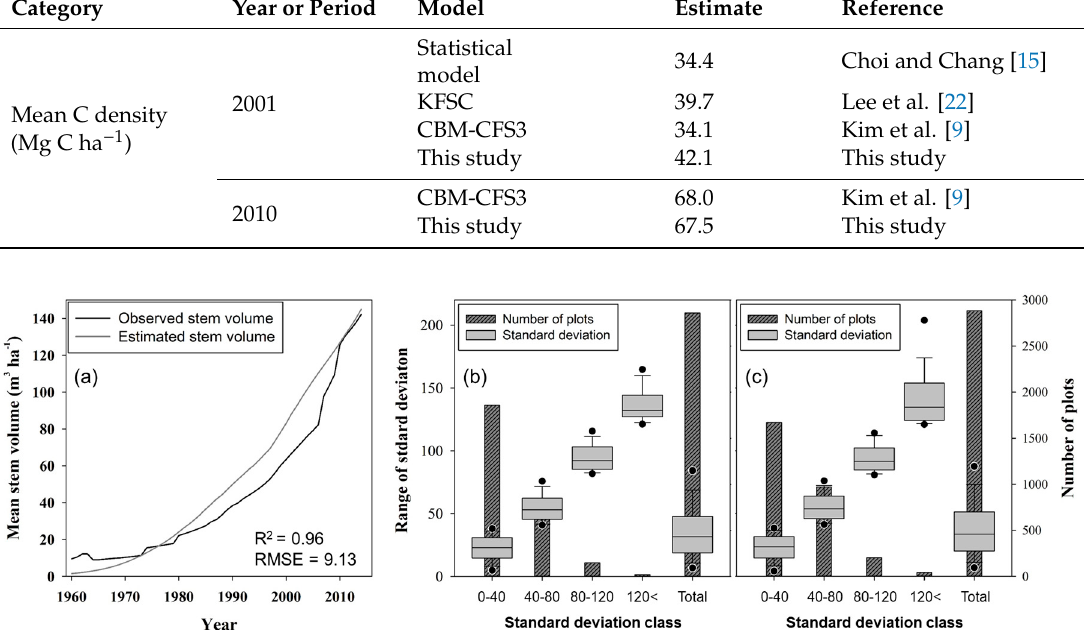
Figure 5. ( a ) Time series of the estimated and the observed (statistical data) mean stem volumes in South Korean forests during the simulation period. Distribution of standard deviations in observed stem volume of sub-plots within permanent plots from the ( b ) fifth and the ( c ) sixth Korean National Forest Inventory (NFI) data.